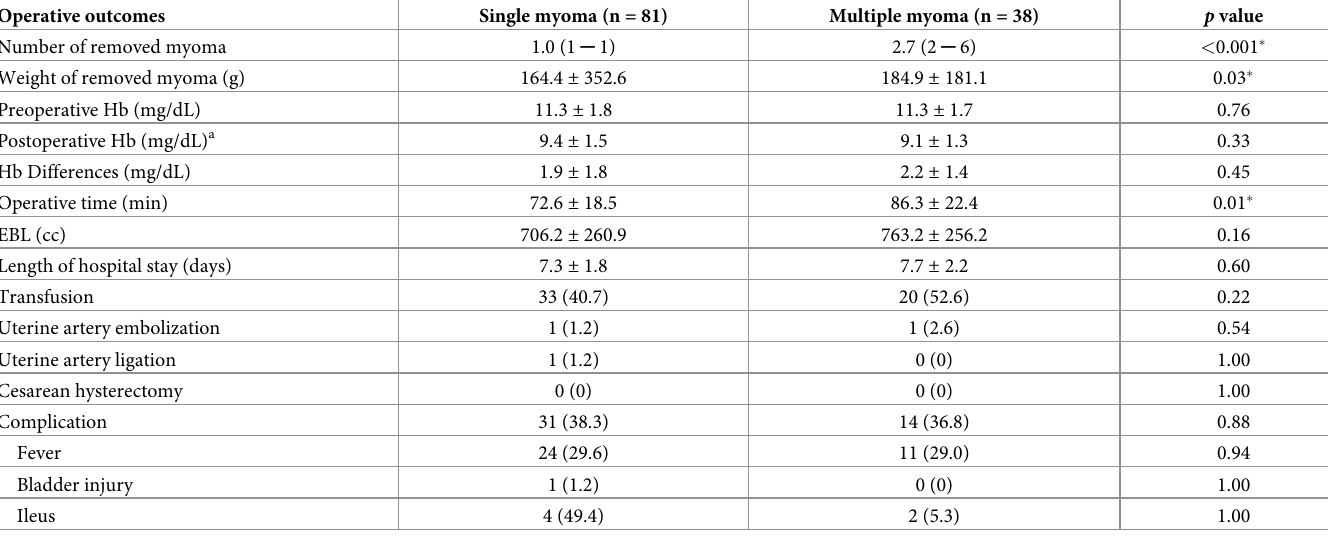
Data are mean ± standard deviation or number (%) Mann-Whitney U test, Fisher’s exact test, Pearson chi-square were used for comparison of two groups.